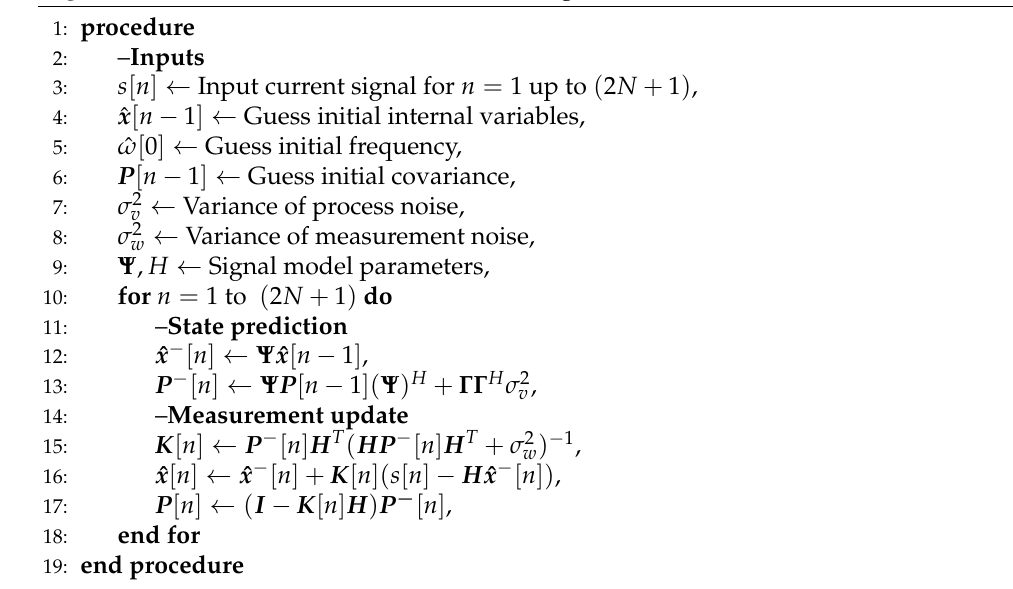
Algorithm 1 Pseudocode of the Kalman filter